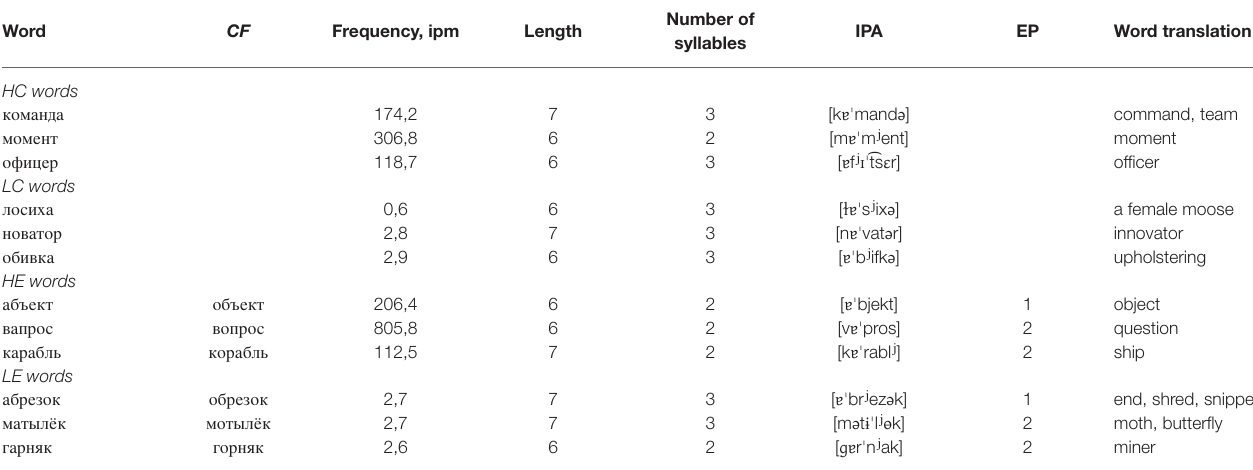
TABLE 2 | Examples stimuli for each condition in the ERP